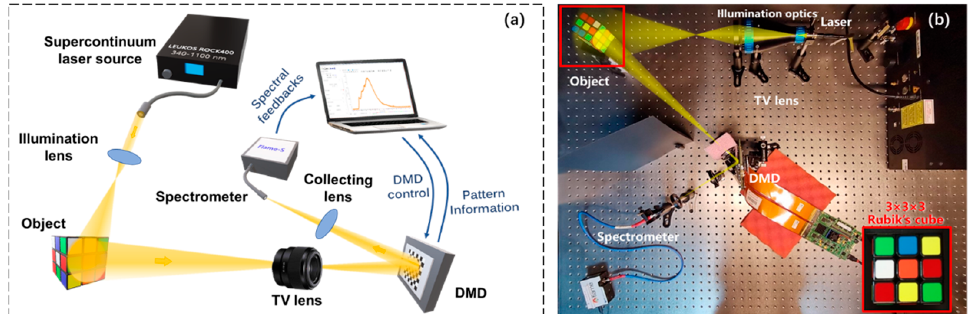
Figure 5. Schematic ( a ) and photograph ( b ) of the CHSPI setup.